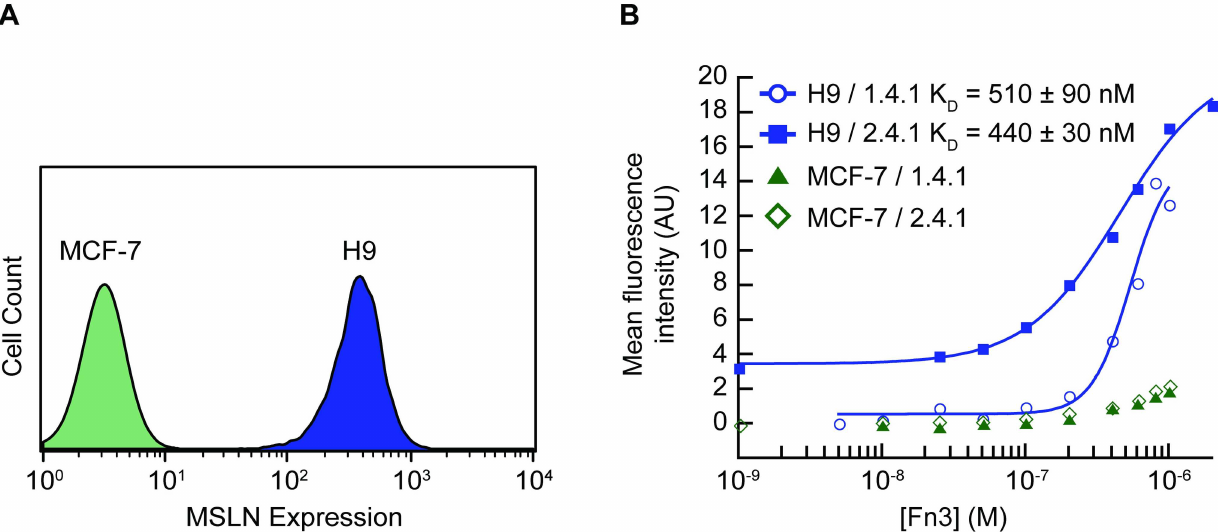
Fig 5. Engineered Fn3 protein variants bound cancer cells expressing MSLN. A431/H9 cells, epidermoid carcinoma cells transfected to express high levels of MSLN, and MCF-7 cells, breast cancer cells lacking surface MSLN, were used in all binding assays. (A) Analysis by flow cytometry confirms MSLN presence on the surface of A431/H9 cells as detected by an anti-MLSN antibody. The MCF-7 cell line does not express MSLN. (B) Fn3 variants 1.4.1 and 2.4.1 were isolated and binding to MSLN was measured using equilibrium binding assays. A431/H9 and MCF-7 cells were incubated with a range of concentrations of soluble fluorescently labeled 1.4.1 or 2.4.1. The assays were performed in experimental triplicate. Data from each replicate were fit to a sigmoidal curve, and a K D value was calculated for each replicate. The K D is reported as the mean +/- standard deviation. A representative binding curve of each clone for both cell lines is